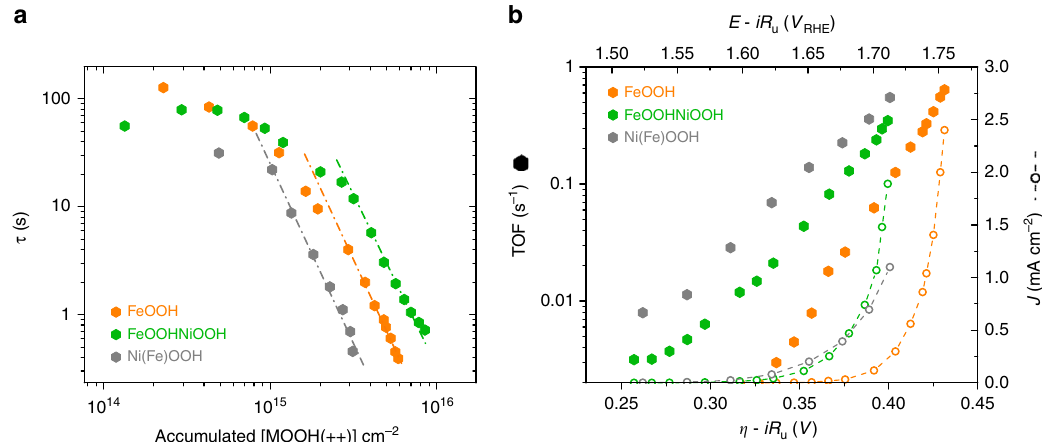
Fig. 4 Kinetics of ( ++ ) species for each electrocatalyst. a Plot of the decay time ( τ ) of accumulated MOOH( ++ ) states against the accumulated MOOH ( ++ ) concentration (solid hexagons) for FeOOH (orange), Ni(Fe)OOH (grey) and FeOOHNiOOH (green). b Corresponding plots of TOF per O 2 generated against the applied overpotential (solid hexagons), overlaid with a plot of current density versus applied potential (empty circles, dashed